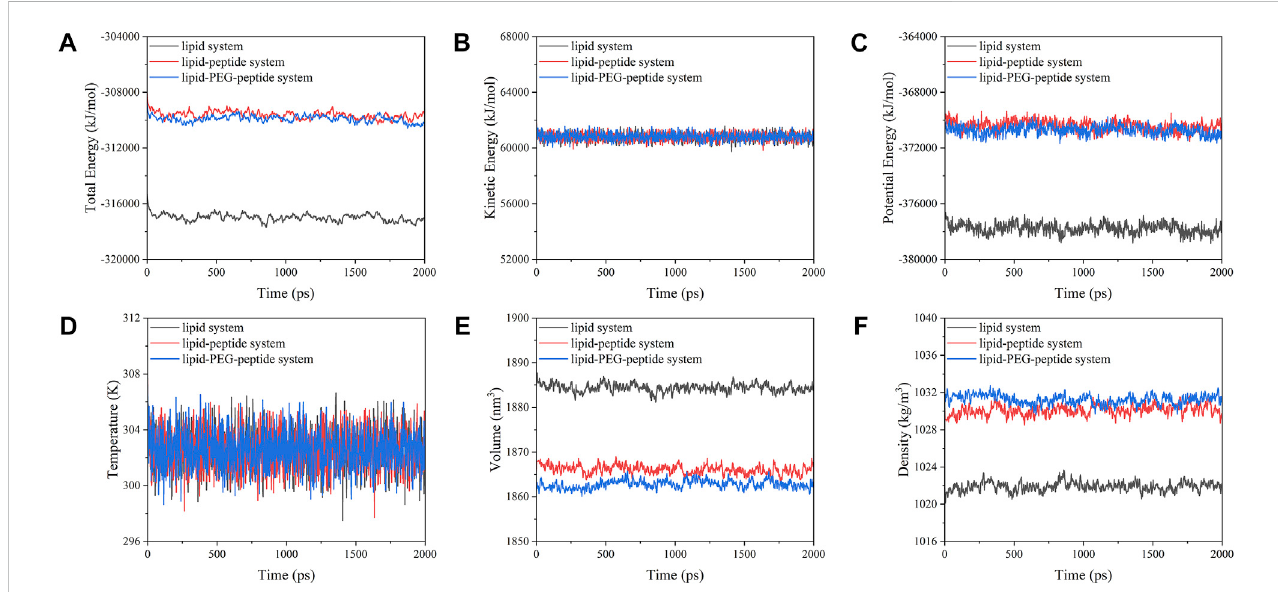
FIGURE 2 Evolution of total energies (A) , kinetic energies (B) , potential energies (C) , temperatures (D) , volumes (E) and densities (F) of the systems with time.